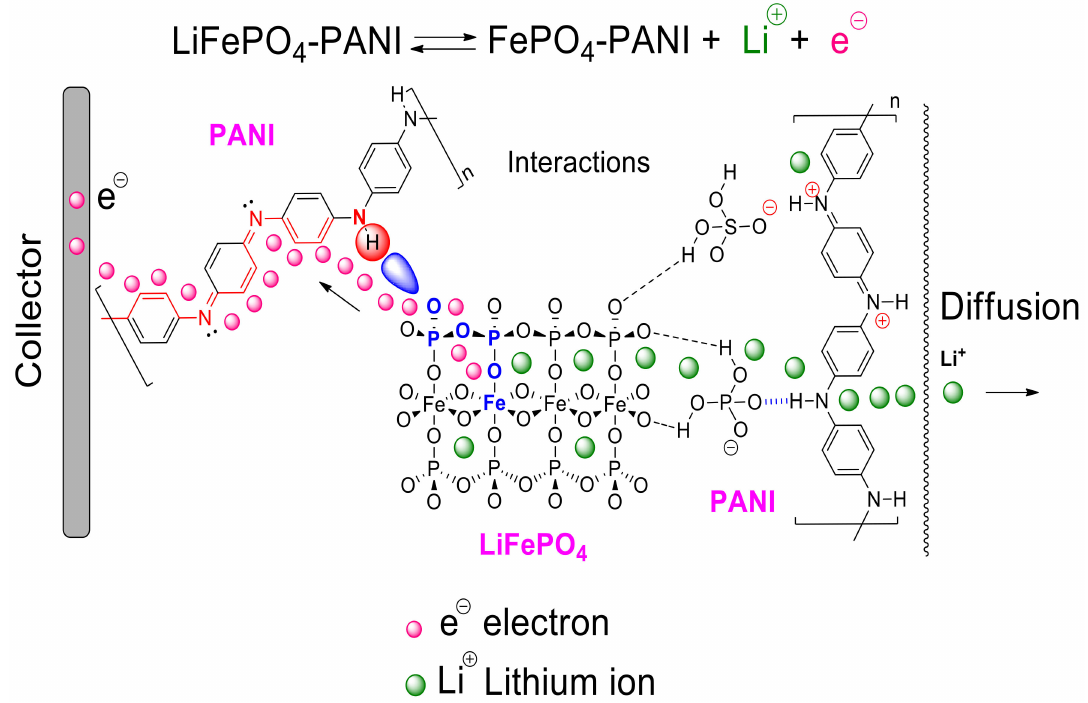
Figure 20. Scheme of the transfer and electron and di ff usion of Li +